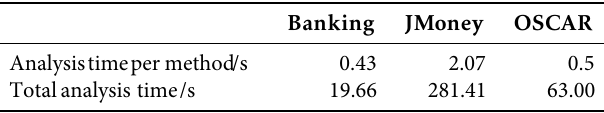
Figure 14. Runtimeperformanceof ourVerificatio